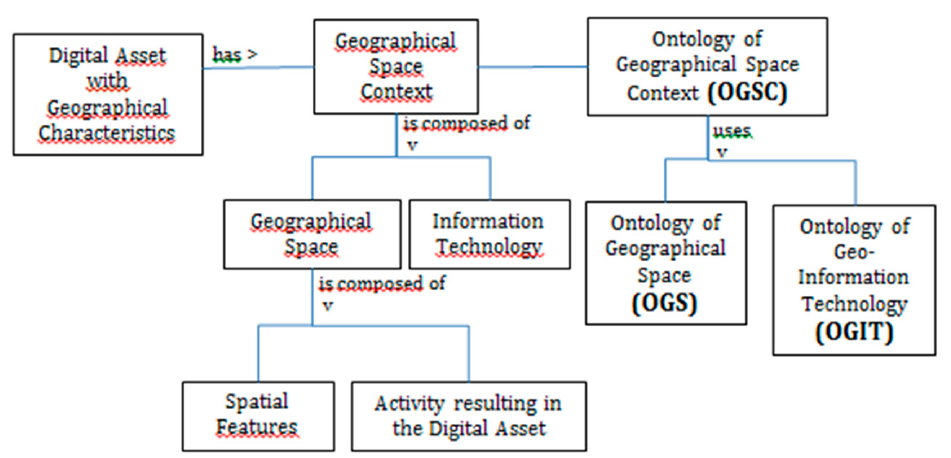
Figure 1. Our proposed referencing framework for improved management of semantics of digital assets with geographical characteristics, either classical SDI components or any other asset, and the needed ontologies. The spatial features are used to specify a CWO or an OWA.